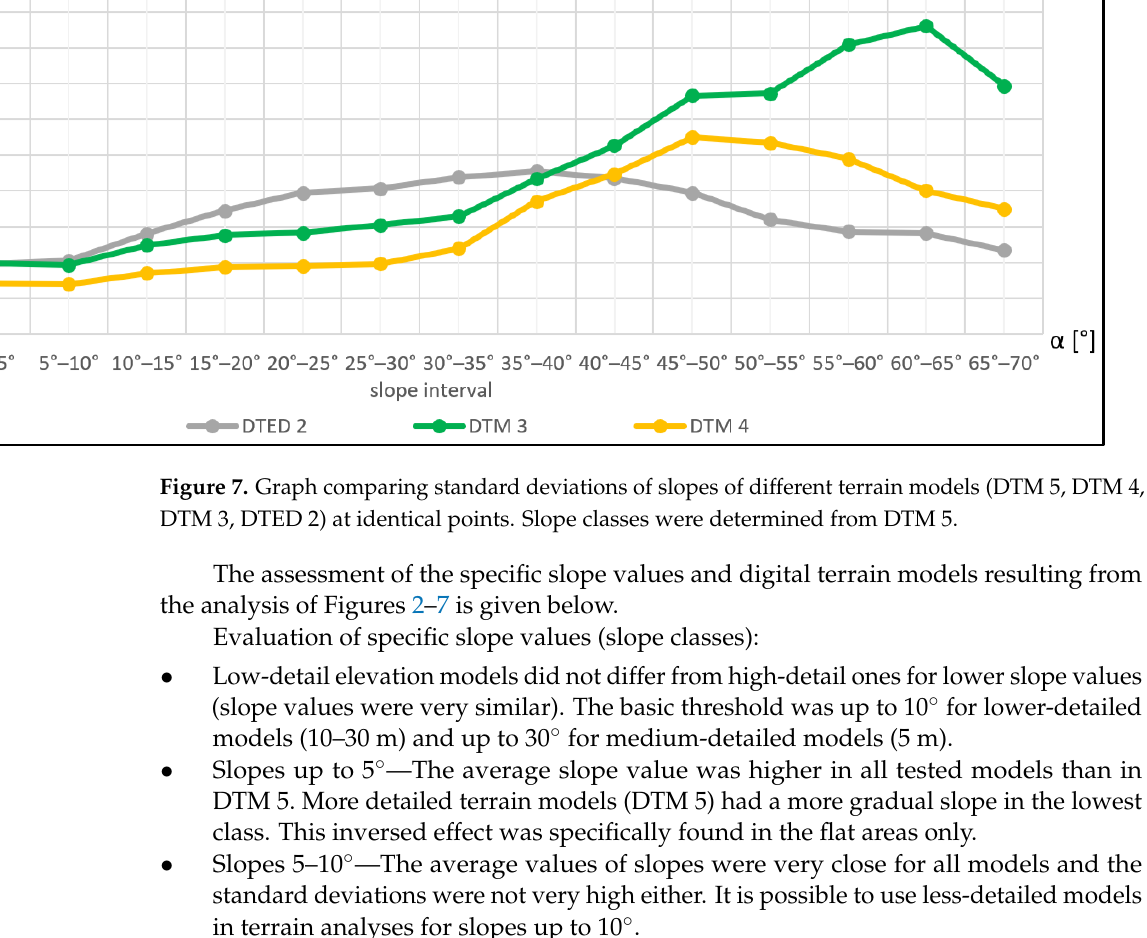
DTM 3, DTED 2) at identical points. Slope classes were determined from DTM 5.